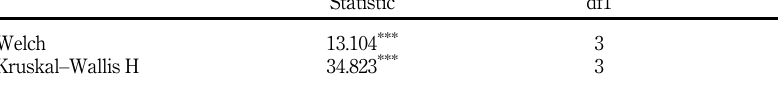
Figure 9. Box plots of cumulative abnormal returns for each issue size